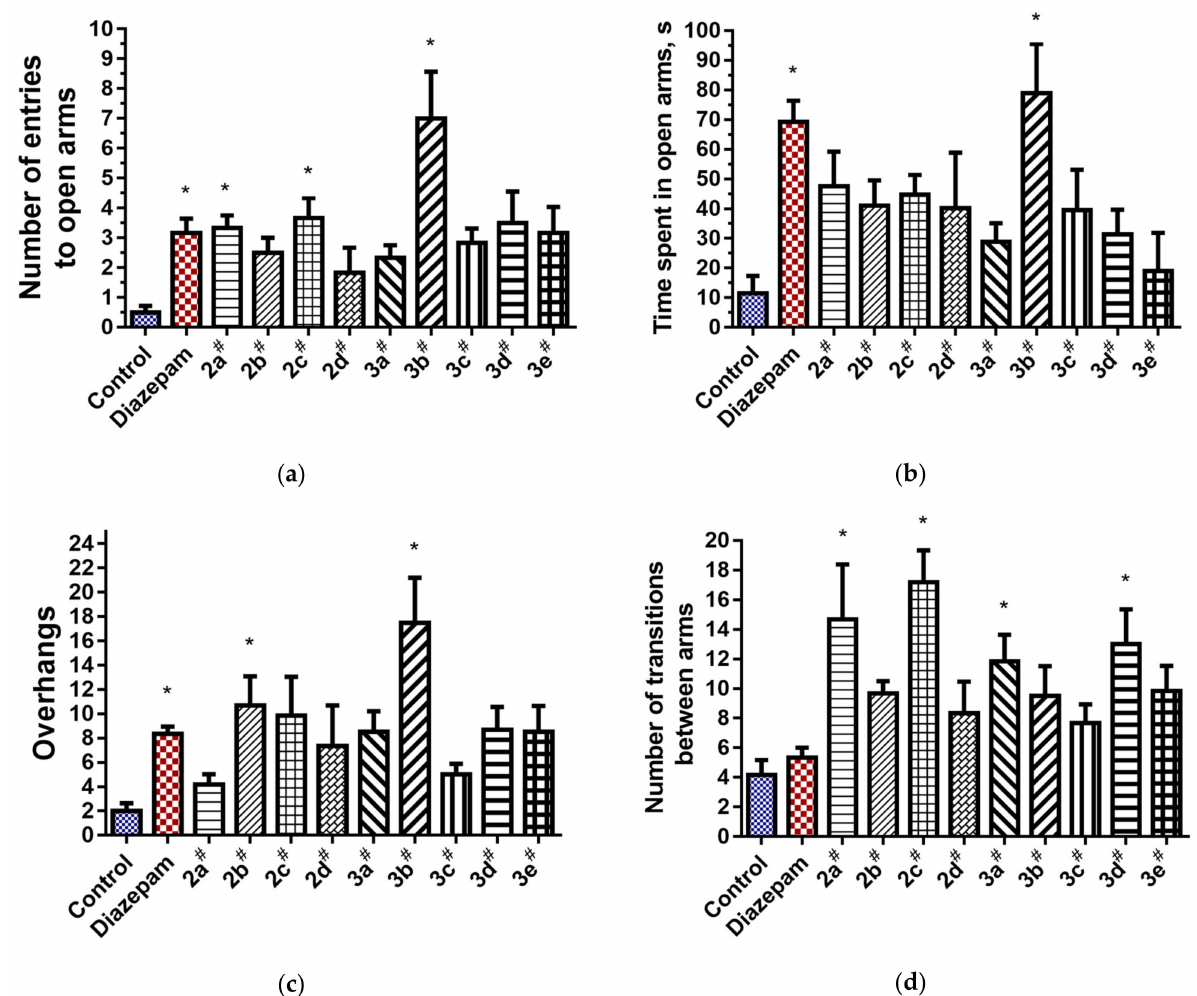
Figure 1. Anxiolytic activity in compounds 2 and 3 in Elevated Plus Maze test in comparison with diazepam (2 mg/kg), mice, per oral administration, M ± SEM: ( a ) number of entries to open arms of EPM; ( b ) time spent in open arms; ( c ) number of overhangs; ( d ) total number of transitions between arms of EPM. Note: * Data are comparable to the control group ( p ≤ 0.05, Kruskal–Wallis test post-hoc Dunn‘s test); # The dose is equimolar to diazepam at a dose of 2